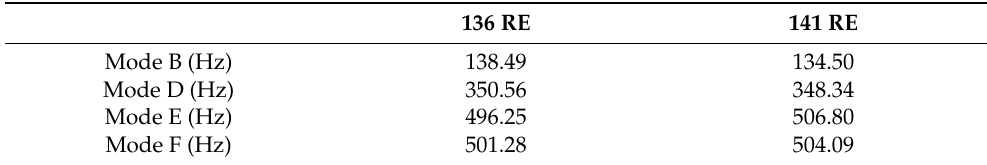
Table 2. Effect of the rail cross-section on the resonant frequencies at a given boundary conditions and at